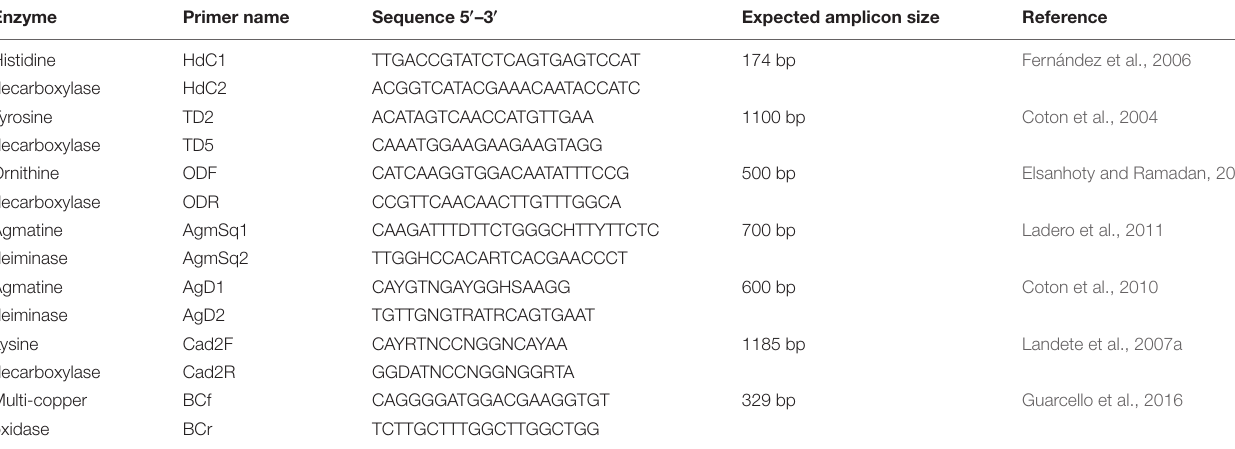
TABLE 1 | Lists of primers to detect the genes involved in the formation and degradation of BAs. Enzyme